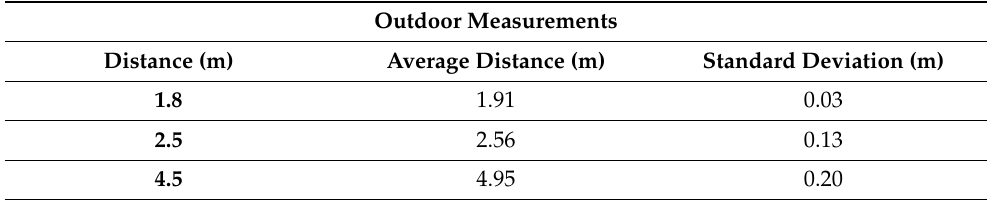
Table 4. Outdoor detection effectiveness.